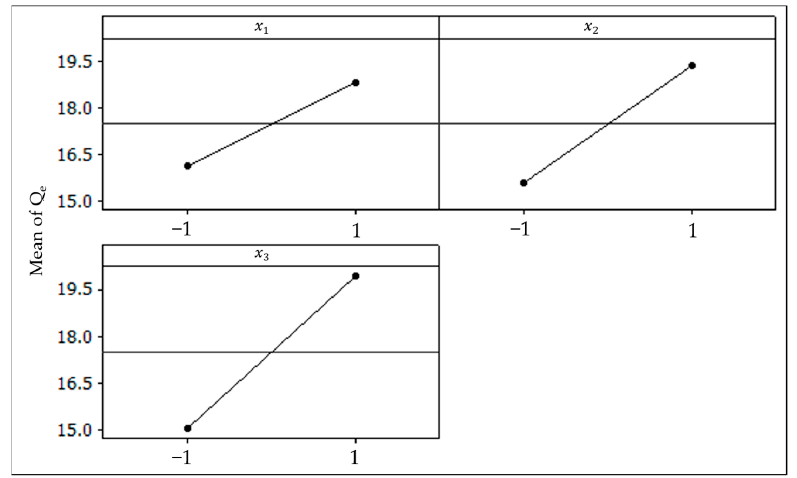
Figure 4. Main effects plots (of temperature, concentration and time) for Qe for the desorption of MB from the clay adsorbent coating.